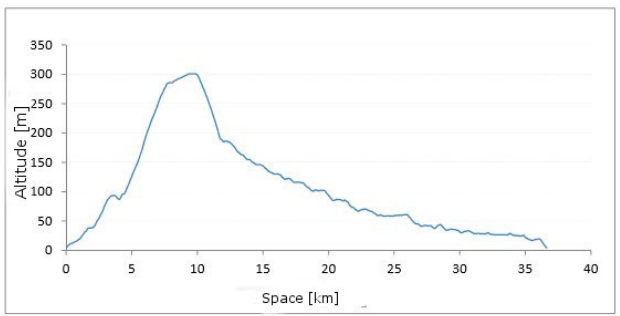
Figure 4. Extra-urban mission elevation profile.